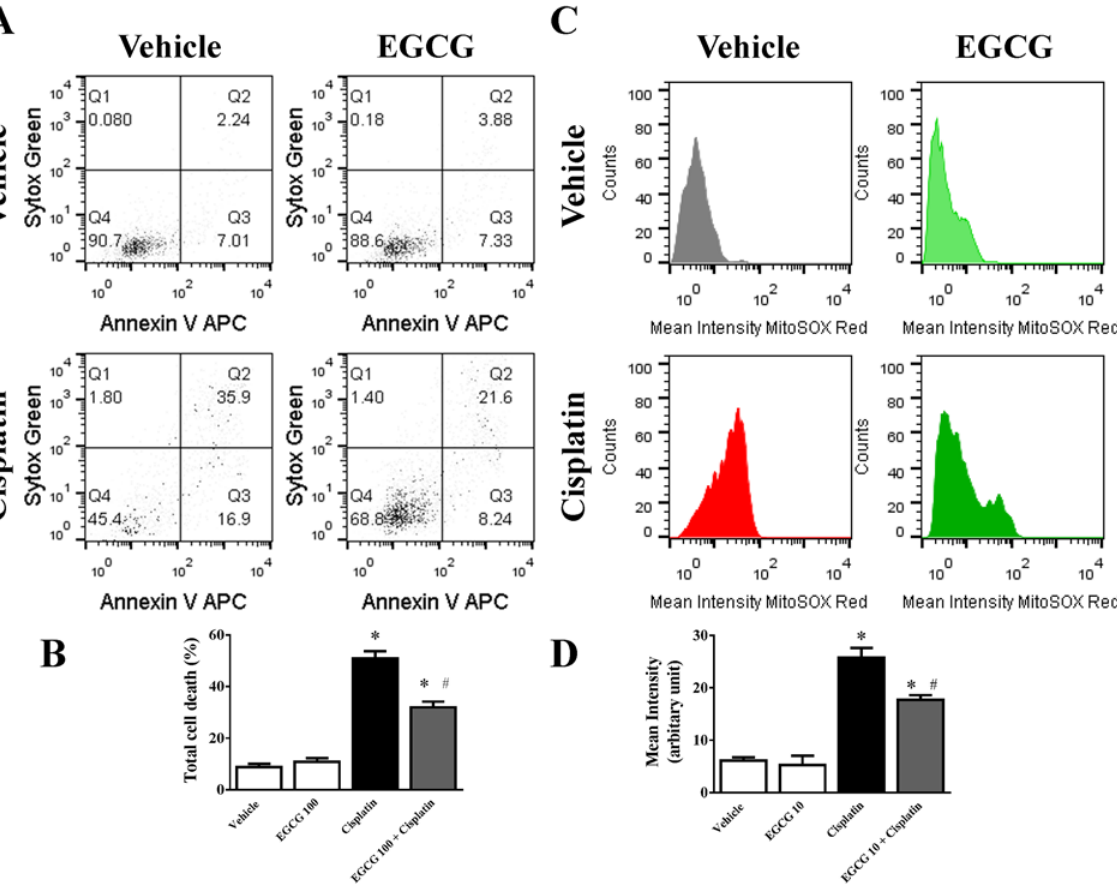
Fig 8. Effect of EGCG on cisplatin-induced apoptosis and mitochondrial ROS generation in HK-2 cells. Panel A: Representative dot plot data showing early apoptosis (AnnexinV-APC staining) and late apoptosis (with Sytox Green) as measured by flow cytometry. Cisplatin was used at 60 μ M and EGCG was added at 10 μ M 2h prior to cisplatin addition. Panel B. Quantitative determinations of total cell death including early and late apoptosis were presented. Results are mean ± S.E.M. n = 4/group. * p < 0.05 versus vehicle; and # p < 0.05 versus cisplatin. Panel C: Representative histogram analyses of MitoSOX Red intensities from the same samples were presented. Panel D: Quantitative determinations of MitoSOX Red mean intensities. Results are mean ± S.E.M. n = 4/ group. * p < 0.05 versus vehicle; and # p < 0.05 versus cisplatin.